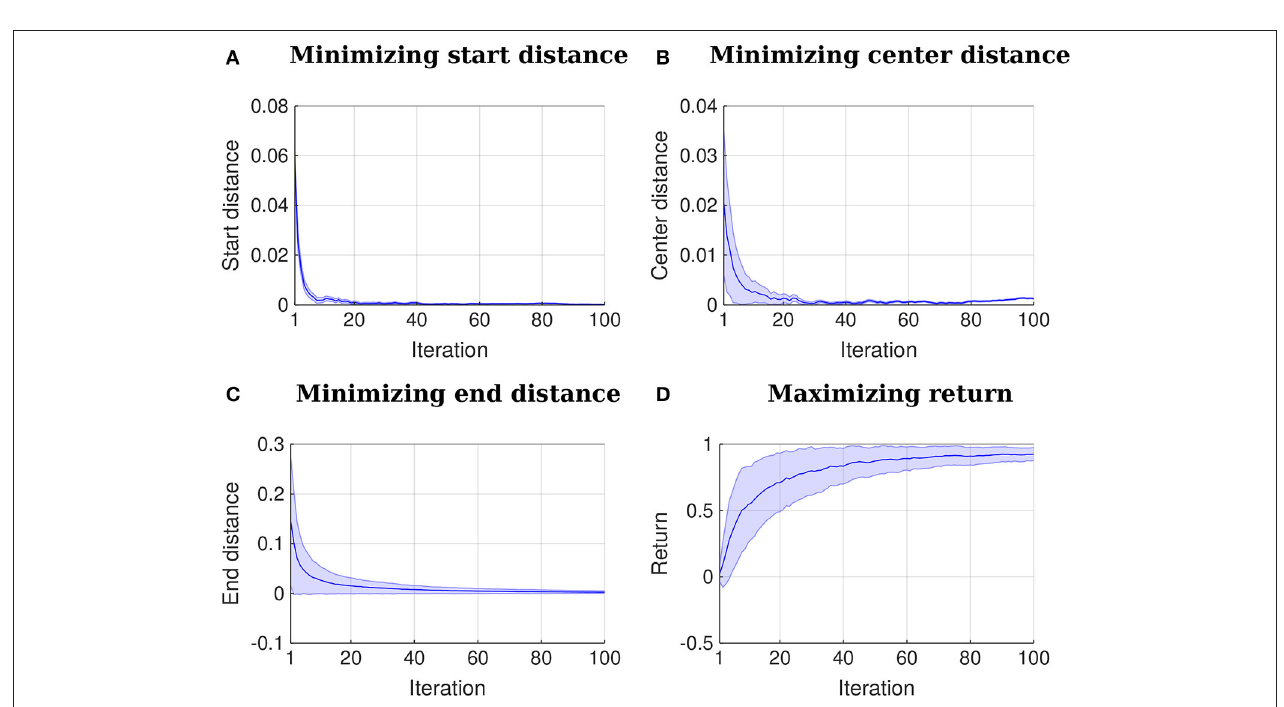
FIGURE 8 | Iteration vs. distances and iteration vs. return. The plots represent mean and two times the standard deviation. All the distances to the points of interest decrease to 0 or close to it with the number of iterations. A return function given by exp Here, β policy is a parameter which can be determined with line search, d start is the distance to the start, d center is the distance to the center and d end is the distance to the